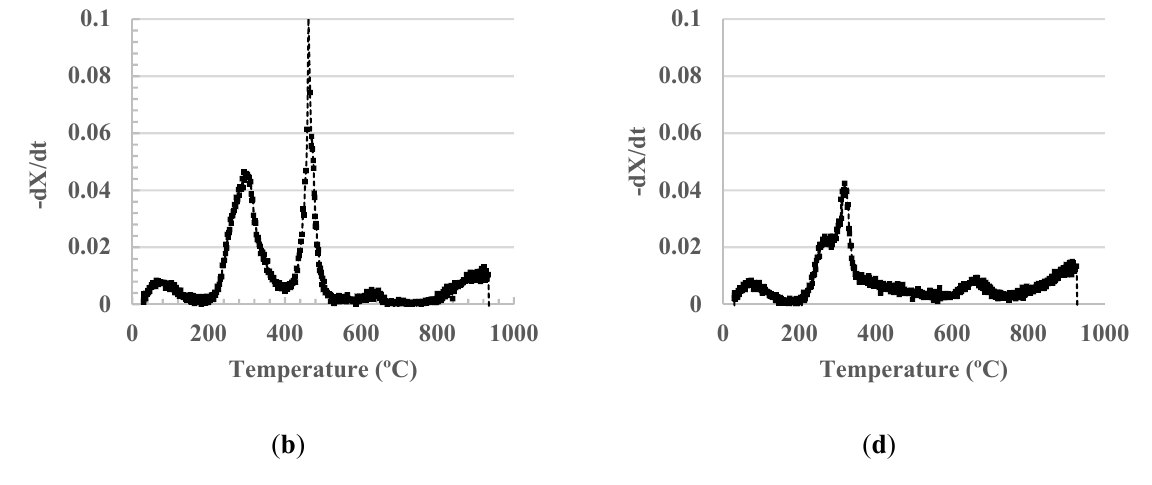
Figure 1. ( a ) TG from biomass combustion; ( b ) DTG from biomass combustion; ( c ) TG from biomass pyrolysis; ( d ) DTG from biomass pyrolysis.